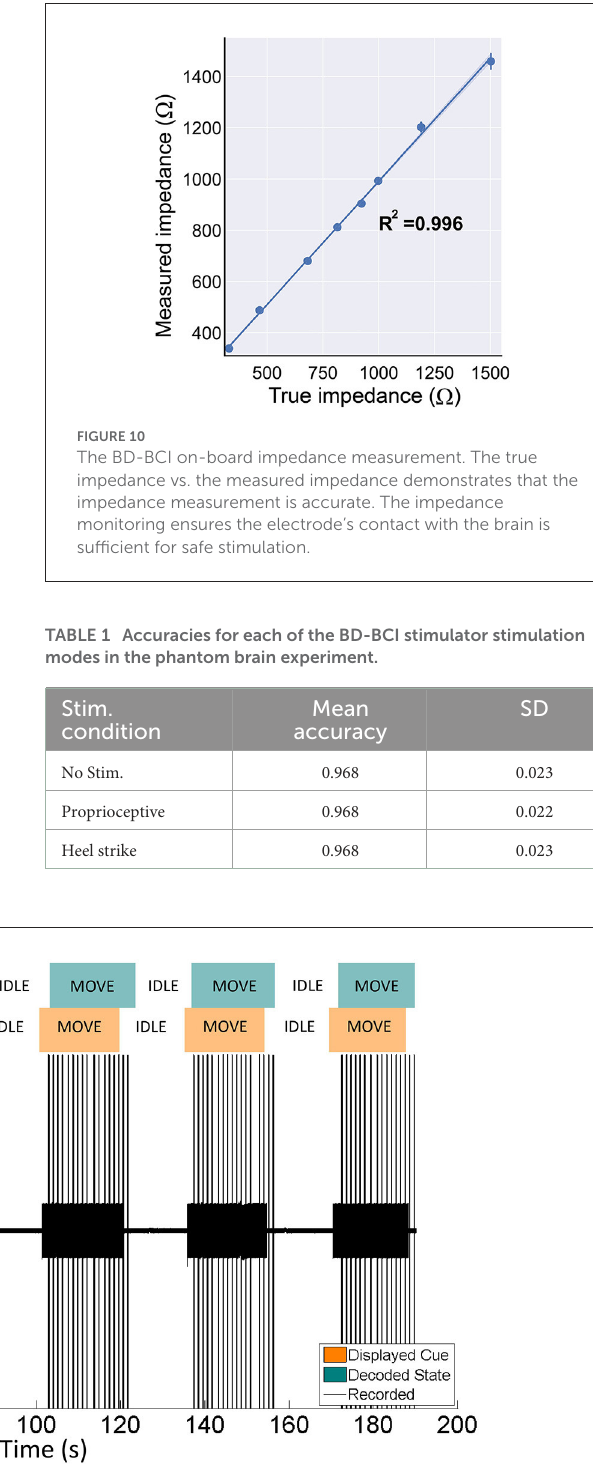
FIGURE11 Representative portion of BD-BCI validation in phantom brain. Eleven move/idle segments are displayed. Orange: The cue, as output by the BD-BCI base station, acts as a ground truth. Green: The decoded state as determined by the BD-BCI. Black: The voltage data from one ECoG channel during BD-BCI operation. The spikes during move states are stimulation artifacts corresponding to stimulation bursts (5 mA current, 250 µ s biphasic pulse width, 200 ms in burst duration) occurring at every simulated moments of heel-strike during imagined walking. The smaller voltage oscillations are the mock motor signal output by the function